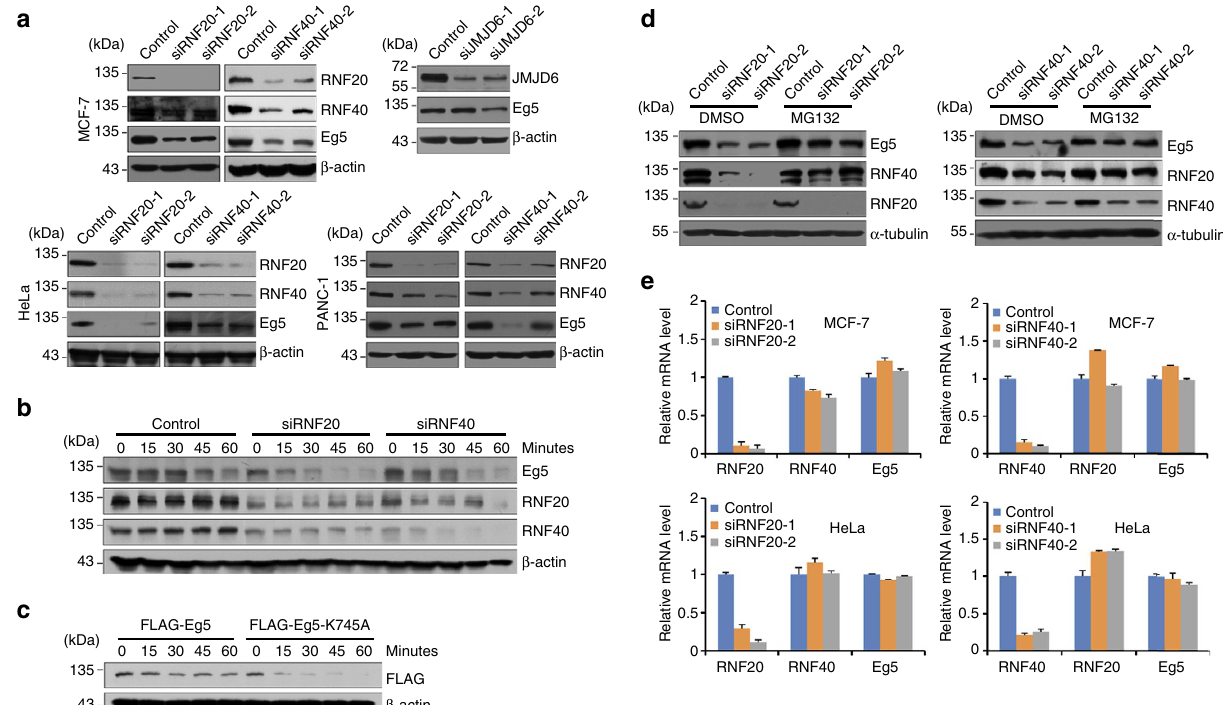
Figure 4 | Monoubiquitination of Eg5 at K745 regulates the stability of Eg5. ( a ) Downregulation of Eg5 by RNF20/40 knockdown in MCF-7, HeLa and PANC-1 cells. Total proteins from cells transfected with the control or RNF20/40 siRNAs were extracted and western blotting was performed using antibodies against the indicated proteins. ( b ) The half-life of Eg5 decreased in RNF20/40-depleted cells. HeLa cells were synchronized at G 2 /M phase by nocodazole arrest, and then treated with CHX (50mgml (cid:2) 1 ) for 0, 15, 30, 45 and 60min before they were analysed for the level of Eg5 protein by western blotting using anti-Eg5. ( c ) The half-life of FLAG-Eg5K745A is shorter than that of wild-type Eg5. HeLa cells transfected with FLAG-Eg5 or FLAG-Eg5K745A were synchronized at G 2 /M phase by nocodazole arrest, and then treated with CHX (50mgml (cid:2) 1 ) for the designated times before they were analysed for Eg5 expression by western blotting using anti-FLAG. ( d ) The RNF20/40 complex protects Eg5 from proteasome-dependent degradation. Western blotting analysis of the expression of Eg5, RNF20, RNF40 and a -tubulin in MCF-7 cells transfected with indicated siRNAs in the presence or absence of MG132. ( e ) Eg5 is not regulated by the RNF20/40 complex at the transcriptional level. Total mRNA from MCF-7 or HeLa cells transfected with indicated siRNAs was extracted and quantitative real-time RT–PCR assays were performed. Each bar represents the mean ± s.d. for triplicate